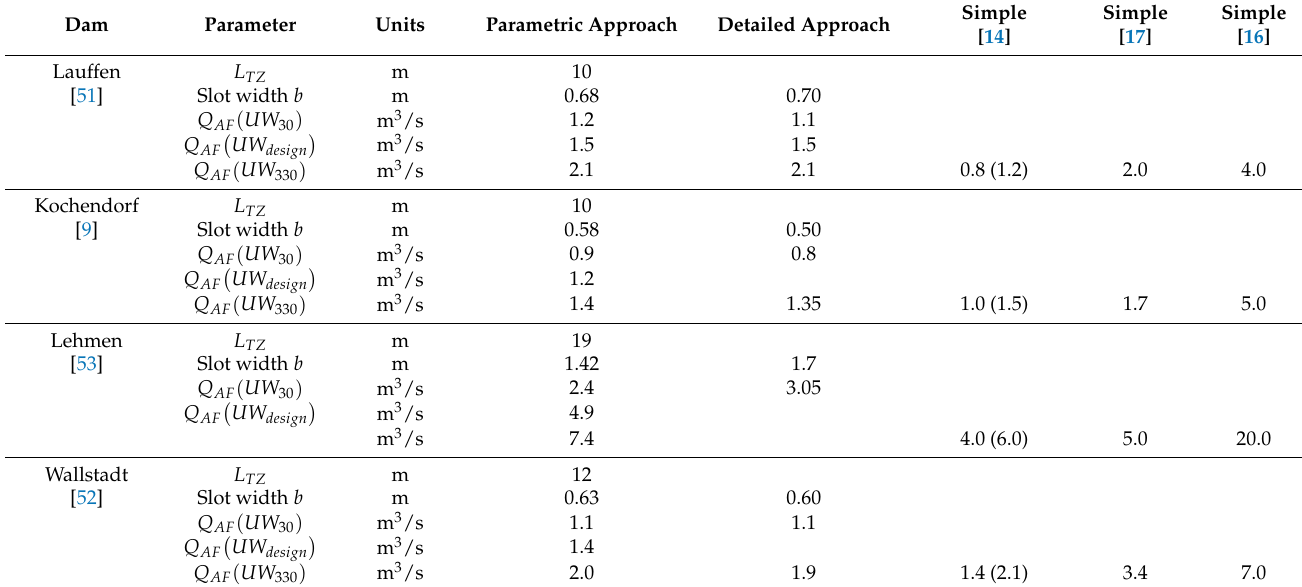
Table 3. Length of turbulent zone L TZ , slot width b and attraction discharge Q AF during different hydraulic conditions for the fishway entrance near the turbine draft tube exit calculated with the parametric design approach, detailed methods and simple approaches for the case study locations; values for [14] are for 1% and 1.5% (in parentheses).